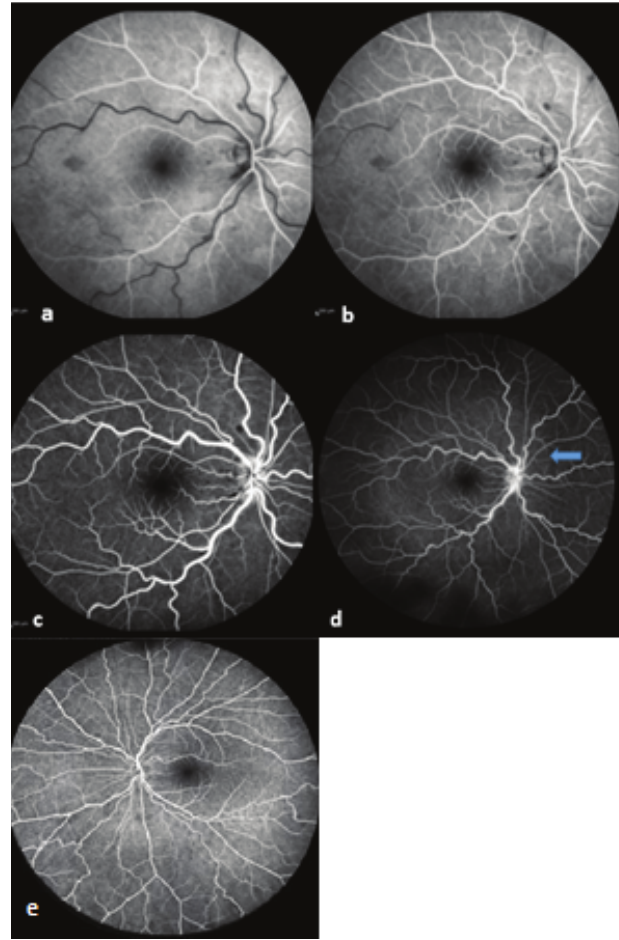
Figure 2. Arterial (a), lamellar (b), and arterio–venous (c) phases of fluorescein angiography (FA) with 55-degree lens shows increased vascular tortuosity and blockage areas due to retinal hemorrhages. Blue arrow: “photopigment bleaching phenomenon” (d). In previously illuminated 55-degree area, hyper-fluorescence area is seen that is surrounded with an unbleached hypo- fluorescent area in 102-degree image. The normal fellow eye 102-degree image at the same time as seen in (d) in which “photopigment bleaching phenomenon” is not visible